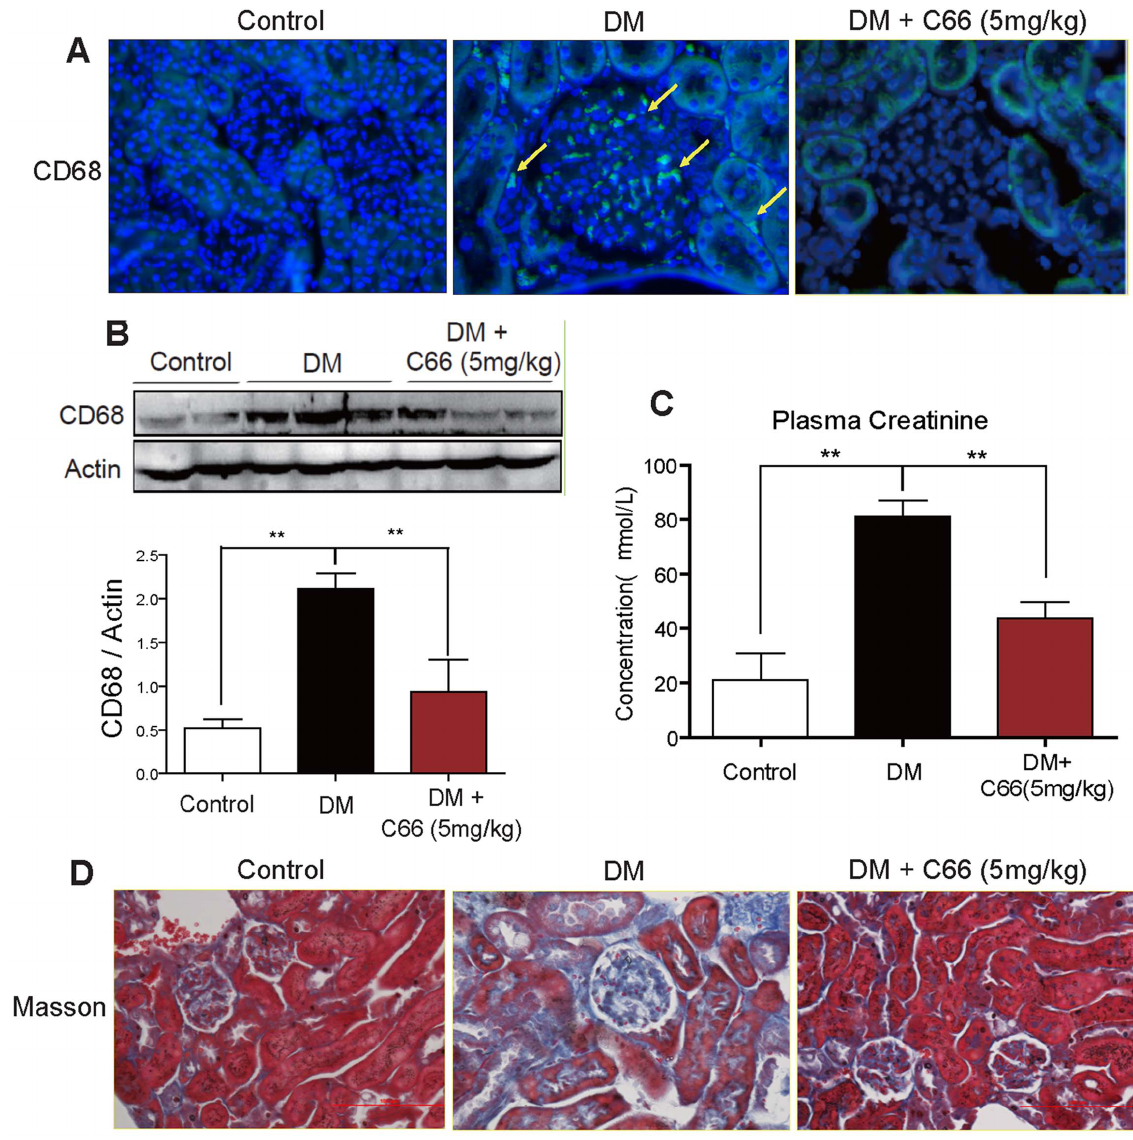
Figure 6. Systemic administration of C66 reduced interstitial inflammatory cell infiltration and reduced renal injury in the kidneys in the diabetic mice. A) Representative photomicrographs showing Macrophage infiltration by immunochemical analysis using anti-CD68 antibodies in the renal tissues (arrows indicate stained macrophages). B) Western blot using anti-CD68 antibodies and densitometric analyses of the renal tissues confirmed such notion. n=6/group, CD68 levels were normalized to actin (* p , 0.05, ** p , 0.01). D) Increased plasma creatinine levels in diabetes were normalized by C66 administration (** p , 0.01). F) Representative masson trichrome stained kidneys (original magnification 6 400 for all) showing diabetes induced increased glomerular fibrosis were corrected by C66 treatment (DM=diabetic